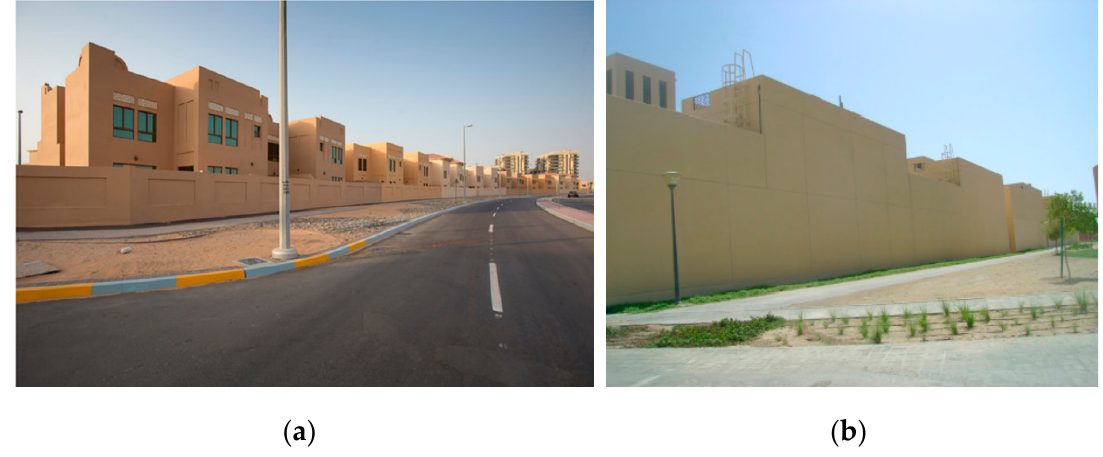
Figure 1 . ( a ) Watani Community, Abu Dhabi ; ( b ) Yas Community, Abu Dhabi. Figure 1. ( a ) Watani Community, Abu Dhabi; ( b ) Yas Community, Abu